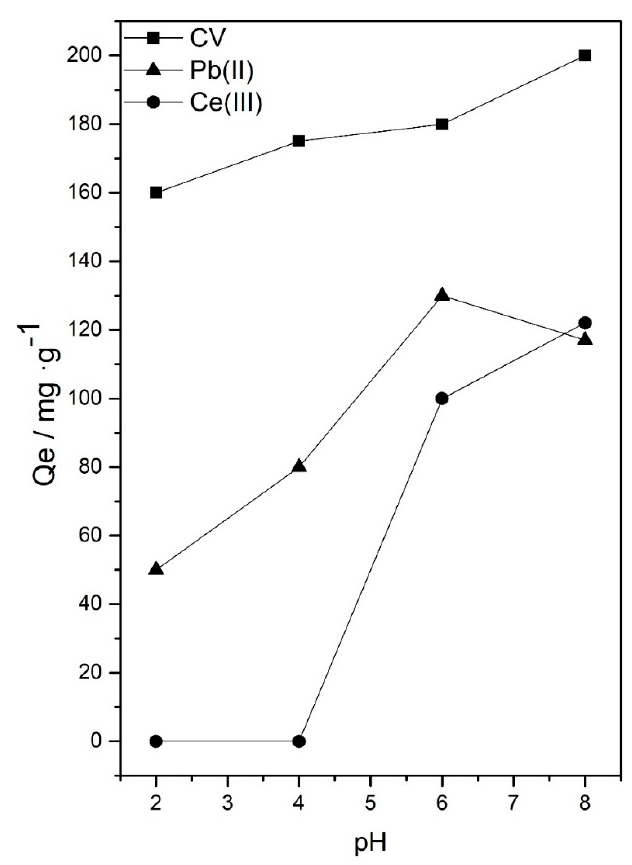
Figure 3. Adsorption capacity of pollutants as a function of pH.